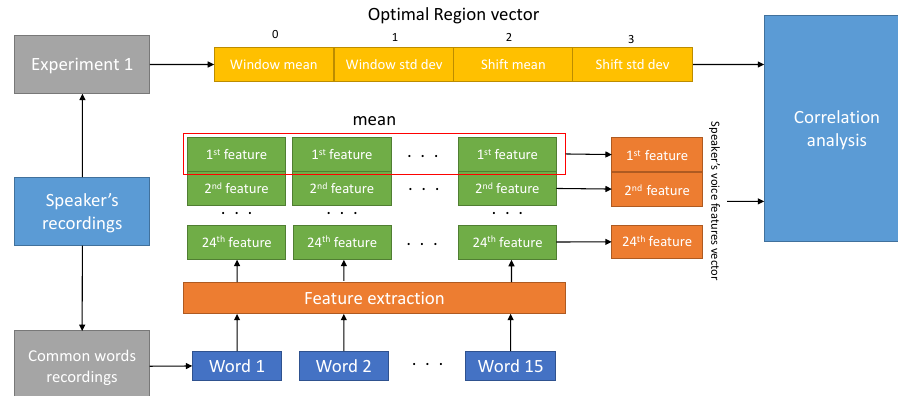
Figure 2. Block diagram of the experiment 2 working